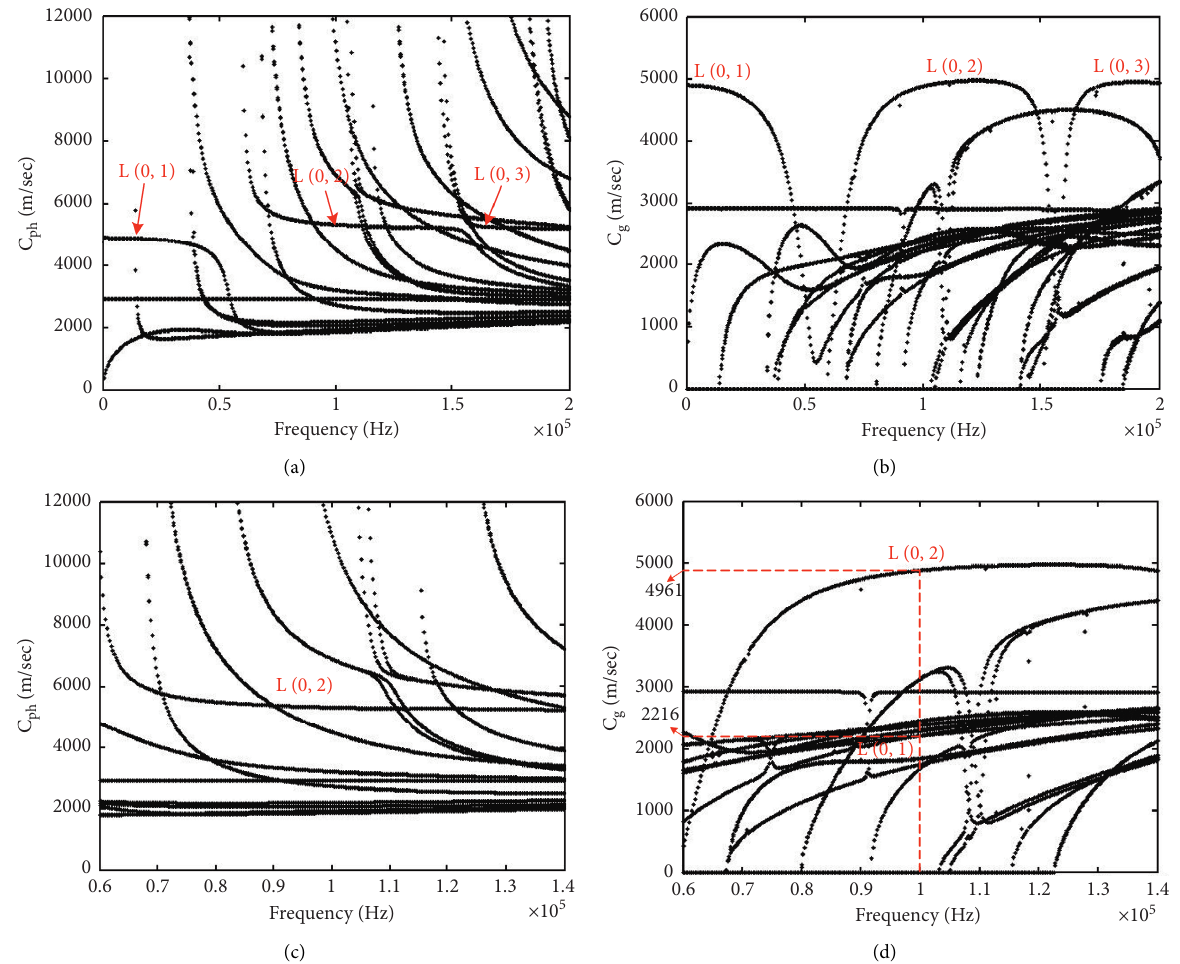
Figure 3: Dispersion curves in the hexagonal pipe structure: (a) phase velocity dispersion curve (0–200kHz), (b) group velocity dispersion curve (0–200kHz), (c) phase velocity dispersion curve (60 kHz-140 kHz), and (d) group velocity dispersion curve (60–140kHz).